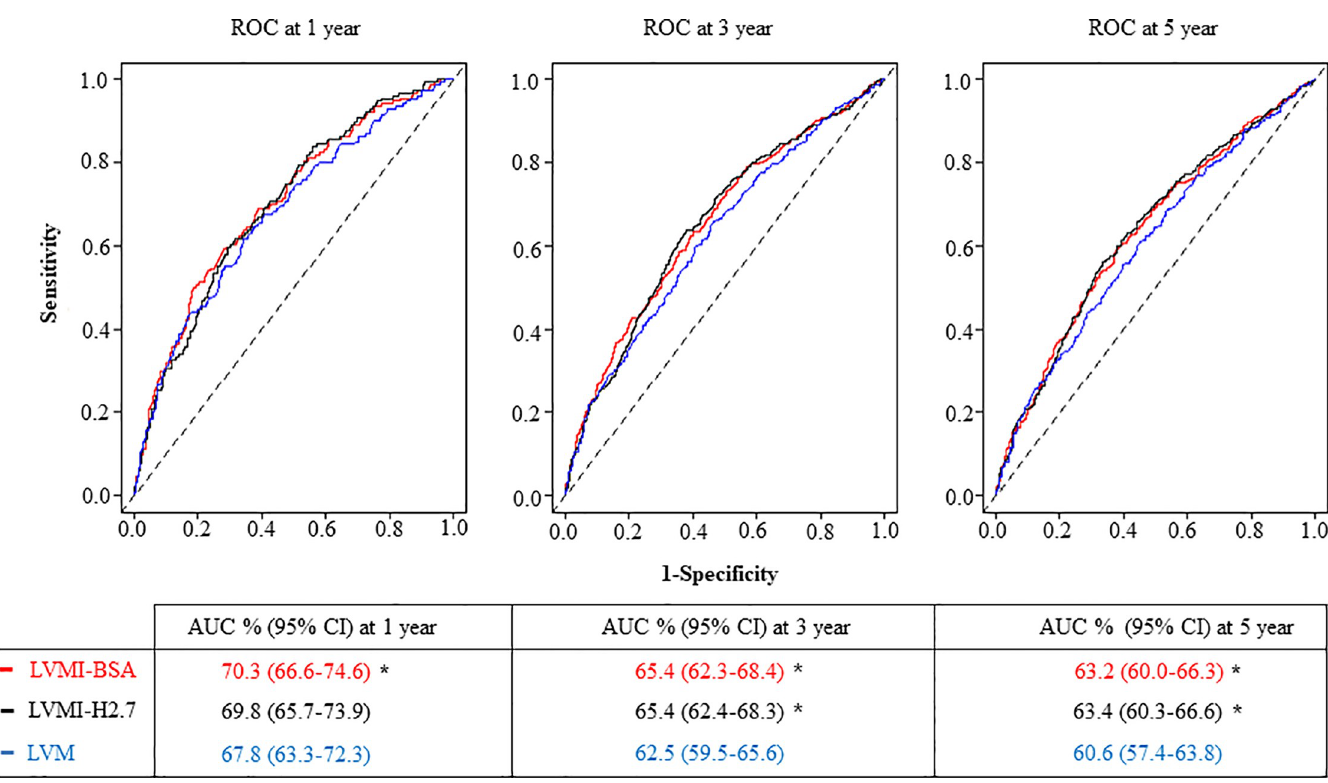
Fig 1. Time-dependent receiver operator characteristics curve of left ventricular mass and its indexations for composite outcome. AUC, area under the curve; CI, confidence interval; LVMI-BSA, left ventricular mass index by body surface area; LVMI-H2.7, left ventricular mass index by height to the 2.7 power; LVM, left ventricular mass; CV, cardiovascular. � meant P < 0.05 when compared to LVM. The P -values of the comparison between AUCs of LVMI-BSA and LVMI-H2.7 were all above 0.05.